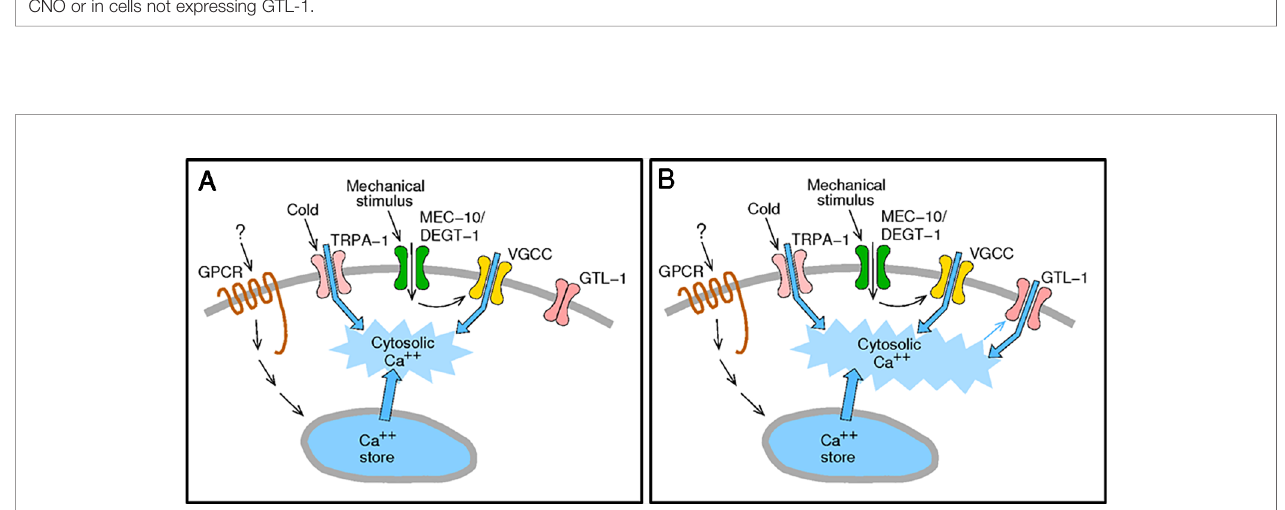
FIGURE 6 | Activation of GTL-1 by internal calcium enables ampli fi cation of sensory stimuli. (A) Sensory stimuli via nocisensor activation directly (TRPA-1) or indirectly (GPCRs and MEC-10/DEGT-1) elevate cytosolic calcium. (B) Elevated cytosolic calcium activates GTL-1 channels to amplify the calcium